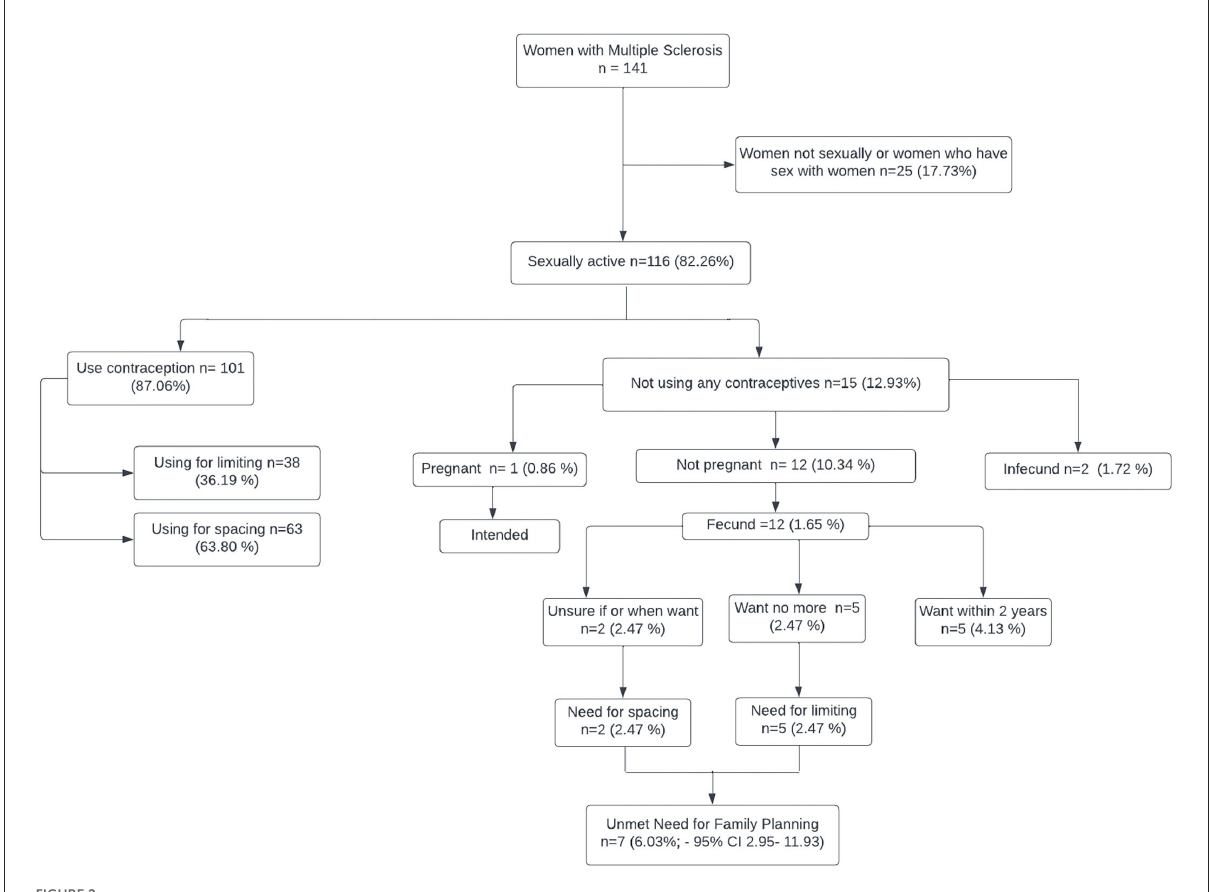
FIGURE2 Unmet need for family planning in women with